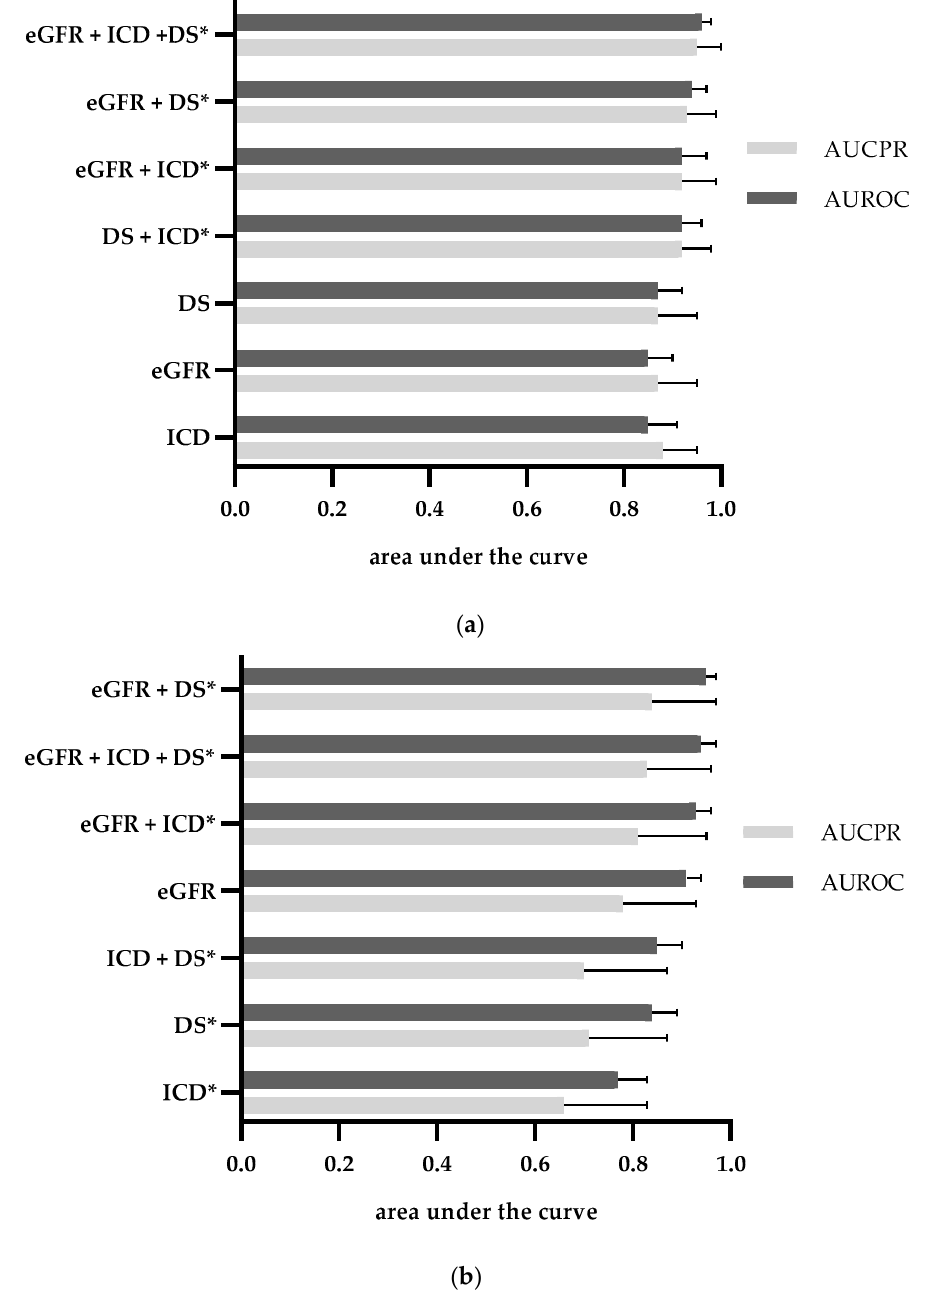
Figure 3. Area under the receiver operating characteristic (AUROC) and under the precision-recall curve (AUCPR) for simple categorical classifiers based on combinations of EHR components for CKD ≥ III ( a ) and NKD ( b ) on the test dataset. eGFR values = “eGFR”, discharge summaries = “DS” and ICD-10 billing codes = “ICD”. For the complete list of all combinations, see Supplementary Materials. Logistic regression was calculated on the training dataset. Performance is calculated on the test dataset (n = 156). * Indicates p < 0.05 for difference in AUROC compared to eGFR.